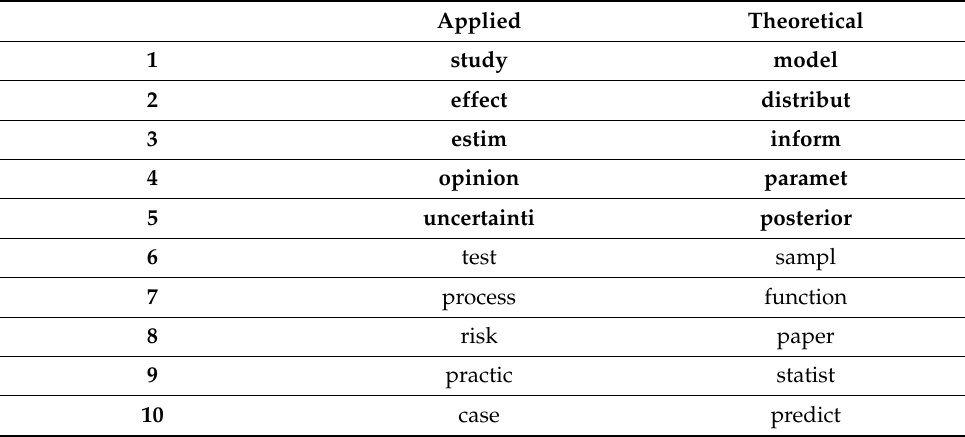
Table 2. Pertinent words according to each LDA topic. In bold are represented the most impor- tant